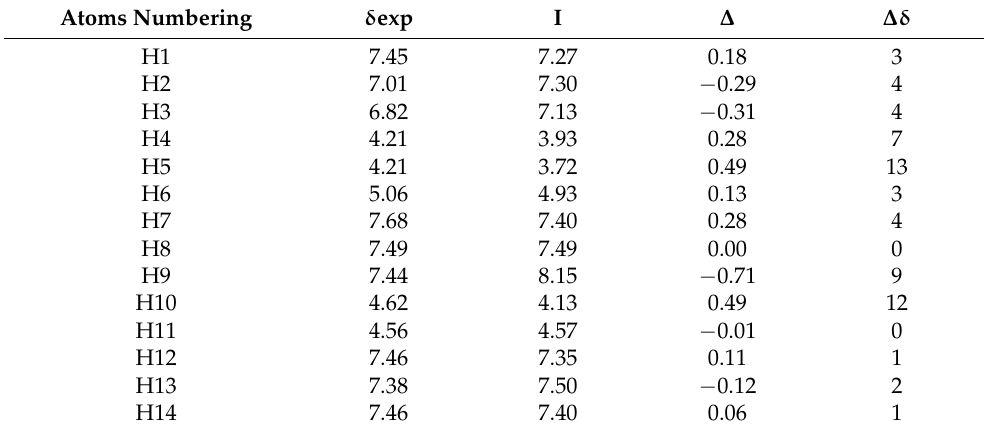
Table 9. Experimental ( δ exp ) and calculated chemical shifts ( I ) for compound 1 ; errors ( ∆ ), relative percentage errors ( ∆ δ ); calculated NMR shielding (B3LYP/631G(d,p)//B3LYP/6-31G(d,p)/DMSO) for proton H ref = 31.7468 ppm for TMS; MAD = 0.25 (atoms numbering as is in Figure 1). Atoms Numbering δ